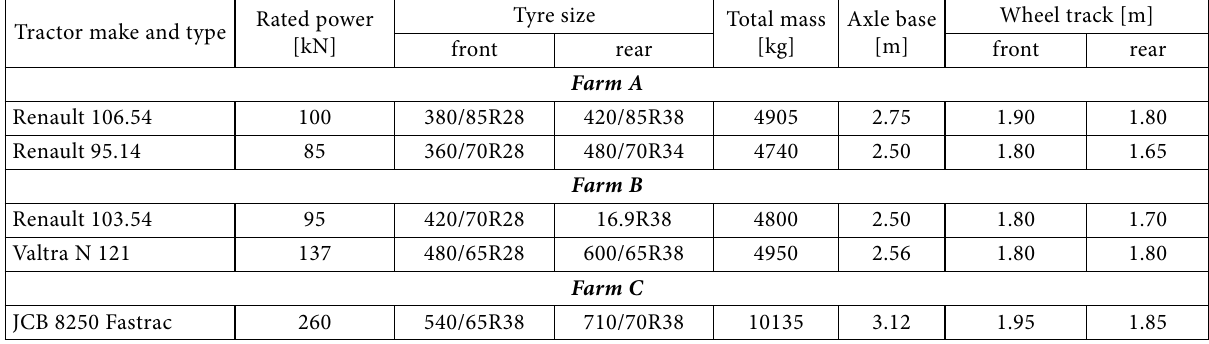
Table 1. Shortened technical characteristics of tractors